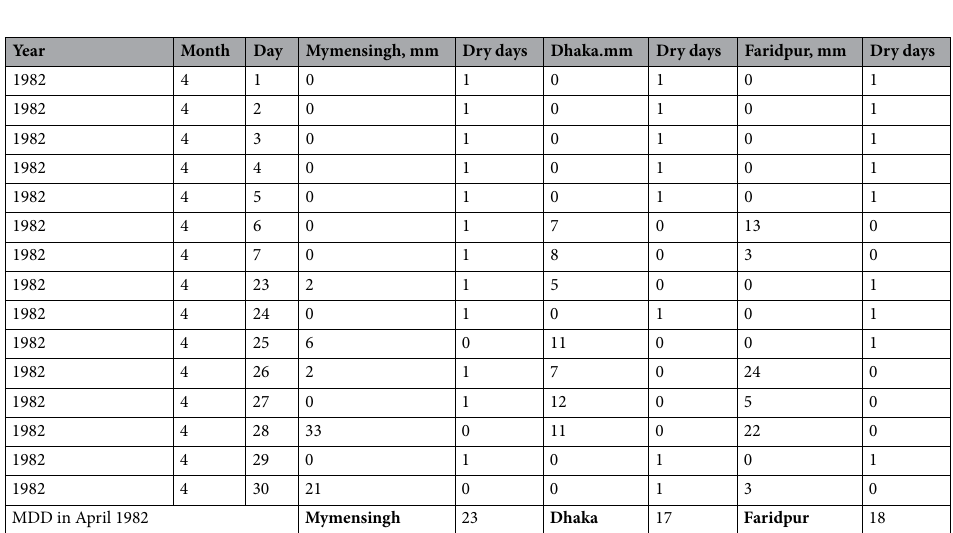
Table 6. Calculation of dry days when a day has a rainfall less than 2